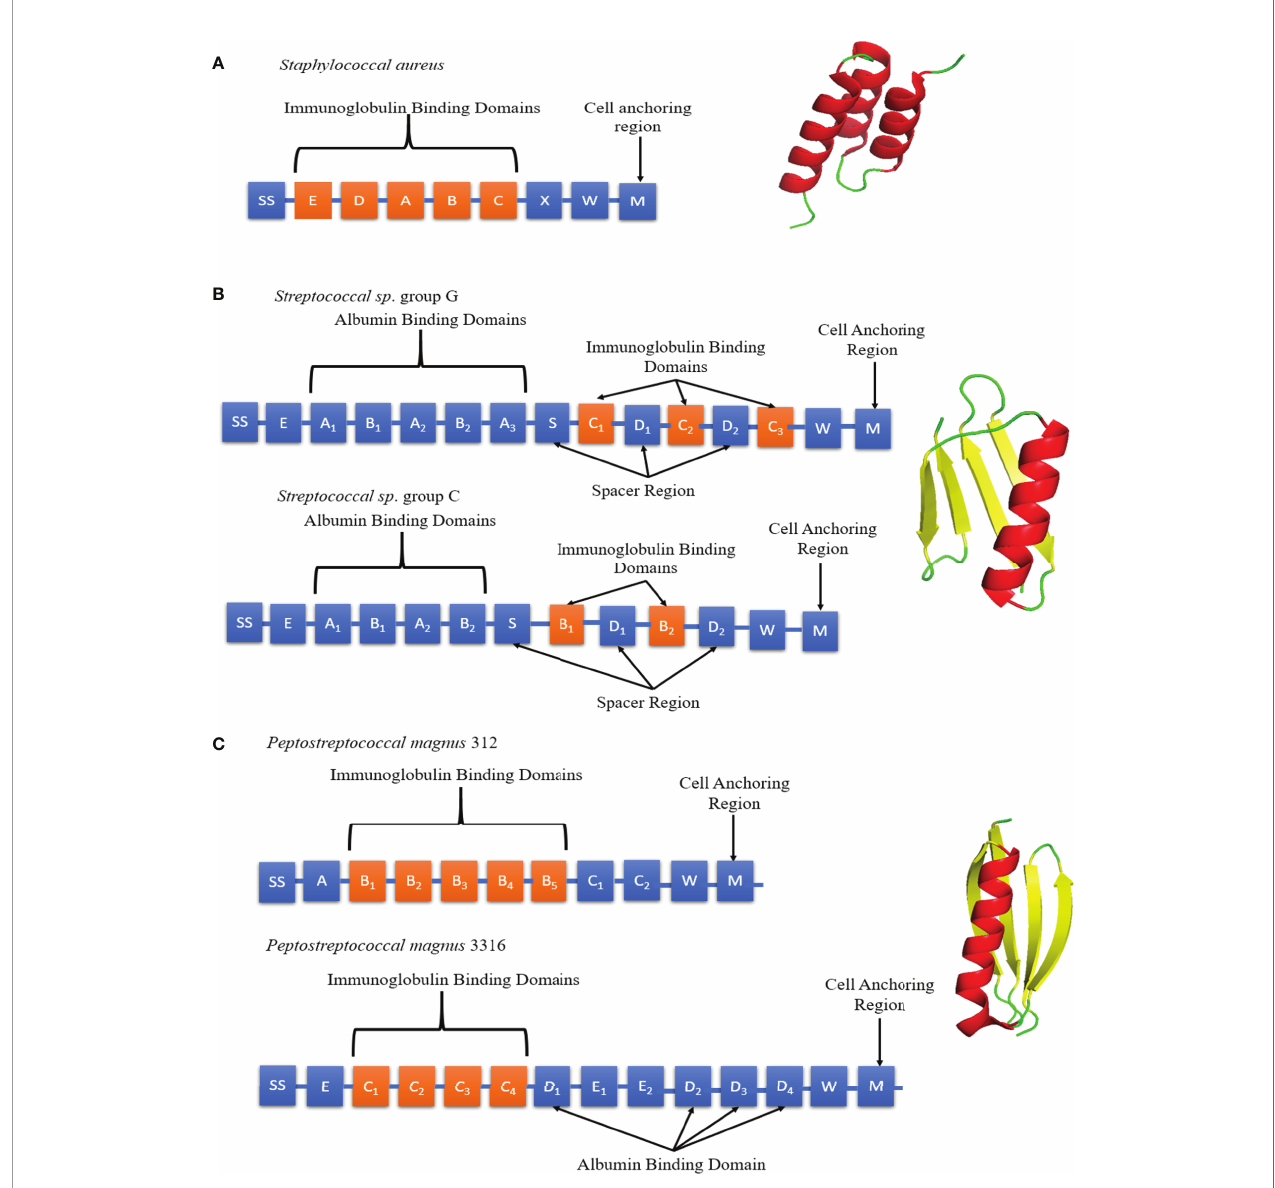
FIGURE 5 | Schematic diagrams of SpA, SpG and PpL domain structures. (A) Left panel: Individual SpA domains including S (sorting peptide), Domains E-D-A-B-C, Region X and Region M. Right panel: SpA Domain C (PDB code: 4WWI) Each SpA immunoglobulin binding domains consists of 3 a -helices (red). (B) Left panel: Individual SpG domains including S (sorting peptide), Region E, Albumin Binding Domains A1-A2-A3, immunoglobulin binding domains B1-B2/C1-C2-C3 and Region W. Right panel: SpG Domain B1 (PDB code: 3GB1) Each SpG immunoglobulin binding domain consists of 1 a -helix (red) and 4 anti-parallel b -strands (yellow). (C) Left panel: Individual PpL domains including S (sorting peptide), Immunoglobulin Binding Domains B1-B2-B3-B4-B5/C1-C2-C3-C4, Albumin Binding Domains D1 to D4, Region W and M. Right panel: PpL Domain B1 (PDB code: 1HEZ). Each PpL immunoglobulin binding domain consists of 1 a -helix (red) and 4 anti-parallel b -strands